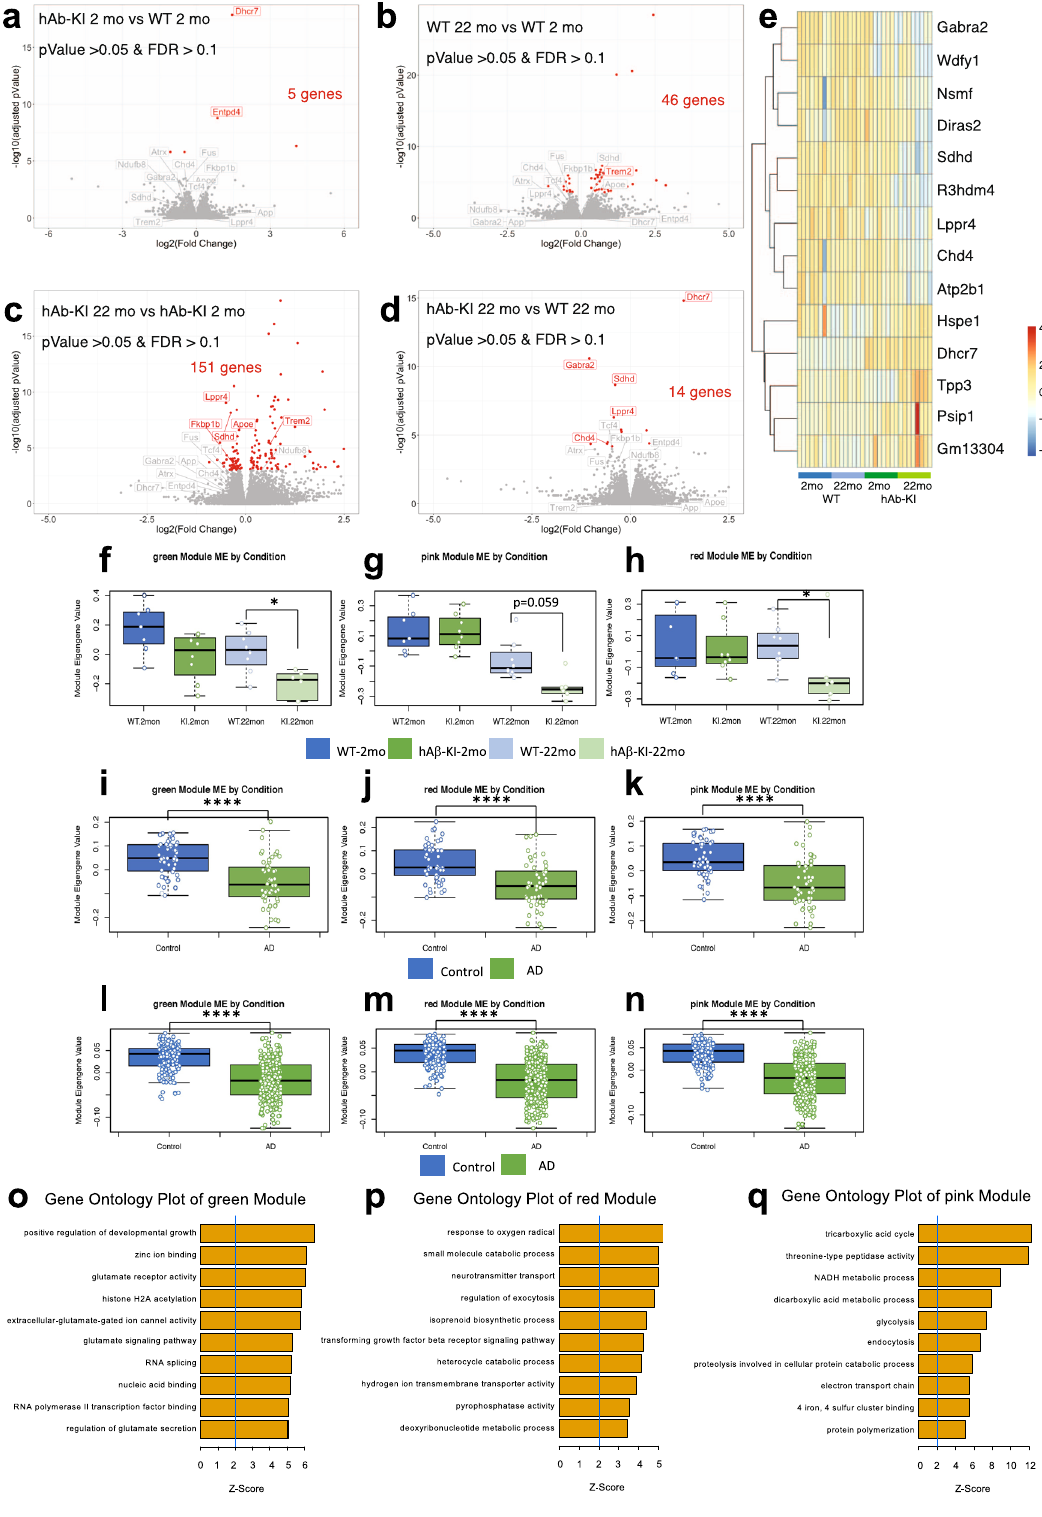
homozygosity of hA β -KI – labeled green, red and pink (FDR q < 0.05, Supplementary Fig. 7). These modules are downregulated in hA β -KI mice at 22-months only but not at 2-months (Fig. 7f – h), consistent with histopathological changes in the hA β -KI mice at 22-months. Cell-type enrichment analysis demonstrated that the red and pink modules are enriched in neuronal marker genes, but the green module is not enriched in any cell-type speci fi c markers